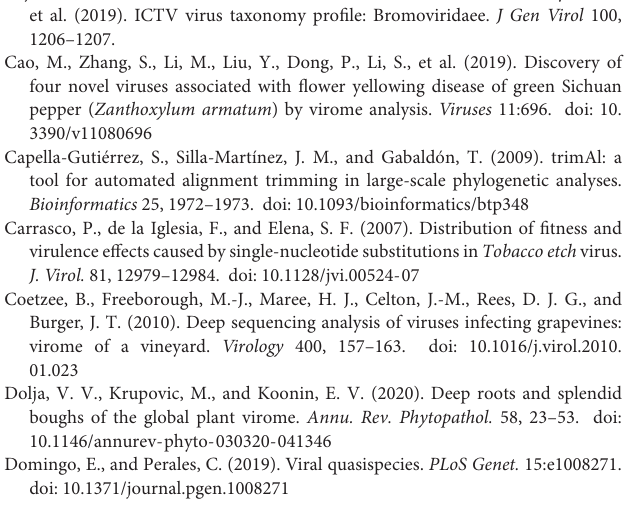
Supplementary Figure 1 | Detection of GSPNeV RNAs and satGSPNeV in an orchard affected by the flower yellowing disease. 1, 2, 4, 6, 8, 9, 11, symptomatic samples; 3, 5, 7, 10, 12, samples without symptoms; + , virus-positive control; H, healthy control; 0, water control. Supplementary Figure 2 | Comparisons of partial genomic terminal sequences from RNAs of green Sichuan pepper-ilarvirus (GSPIlV) suggested sequence conservation and the presence of complete coding sequences in the obtained sequences. Supplementary Figure 3 | Sequence comparisons of genomic RNAs of Sichuan pepper-ilarvirus (GSPIlV) with those of selected related viruses. Cucumber mosaic virus from the genus Cucumovirus was used as an outgroup. Three groups (G1, G2, G2) as subgroups under the genus Ilarvirus are indicated. Supplementary Figure 4 | Comparisons among GSPNeV RNAs and satGSPNeV showed some conserved sequences of the genomic ends. Supplementary Figure 5 | Matrixes of sequence identities between RNAs of different viral/subviral isolates obtained in this study. Supplementary Figure 6 | Correlations of numbers of variation sites from the consensus sequences and quasispecies of different viral/subviral RNAs and the common variation sites between the consensus sequences and quasispecies. Supplementary Table 1 | List of primers used in this